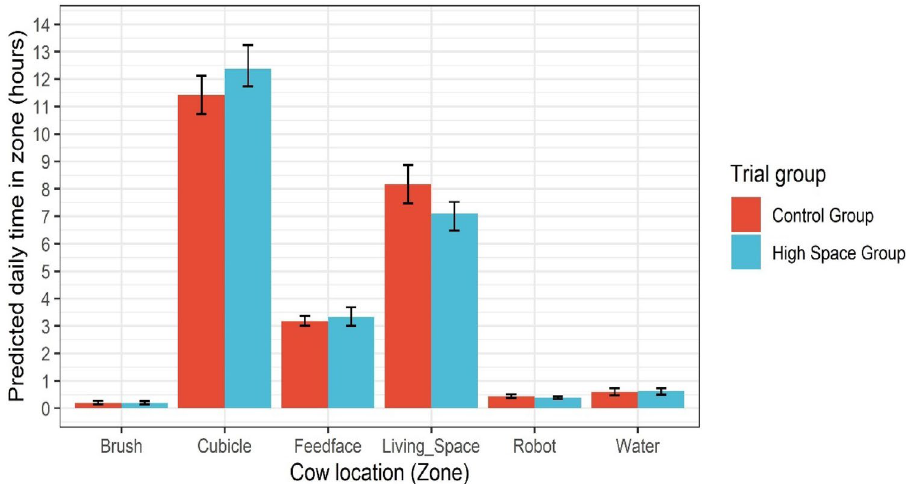
Figure 4. Plot of the final results of the time budgets for cows in each trial group during the sampling period. Cows in the high space group (red) spent significantly more time in cubicles and less time in living space areas in comparison to cows in the control space group (blue). The error bars (black lines) represent the 95% confidence interval of the mean for each location. Cubicle and living space areas show statistically significant differences between trial groups. These graphs are based on location data from a long-term randomised controlled trial which evaluated the impact of living space on the behaviour of housed dairy